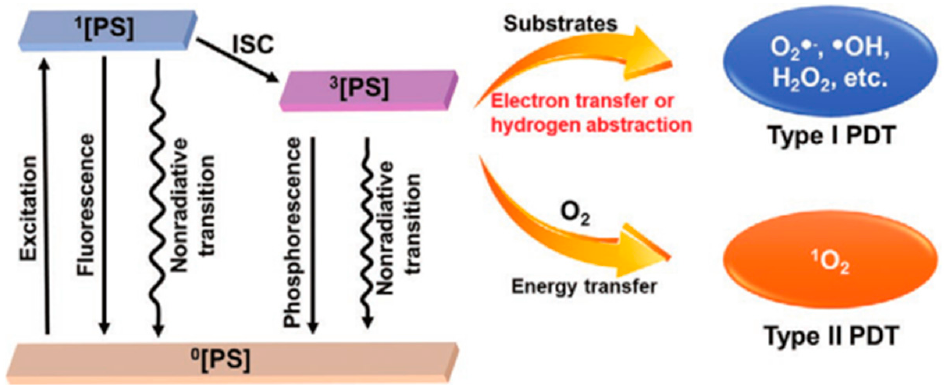
Figure 1. Basic PDT type I and type II process schematic diagram. Reproduced with permission from Ref. [27], Copyright (2021) John Wiley and Sons.